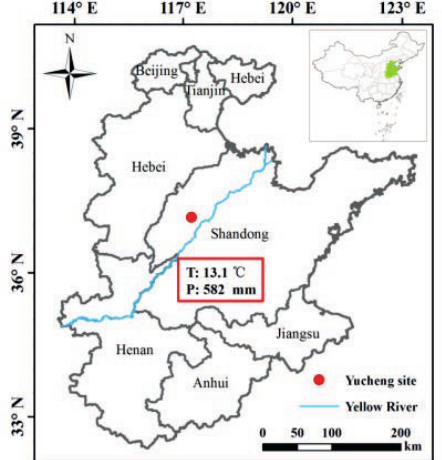
Fig. 1 The location of Yucheng site in